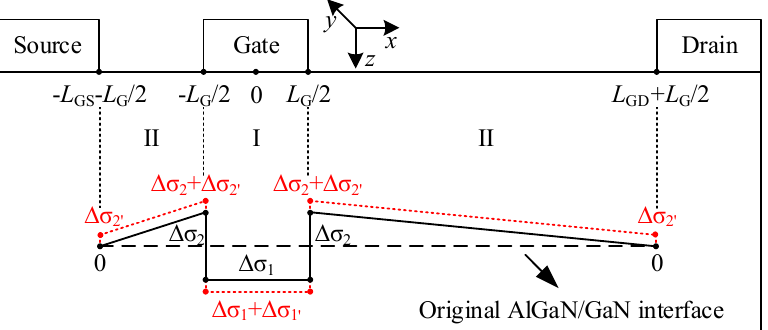
Figure 8. Distribution of additional polarization charges at AlGaN/GaN interface.